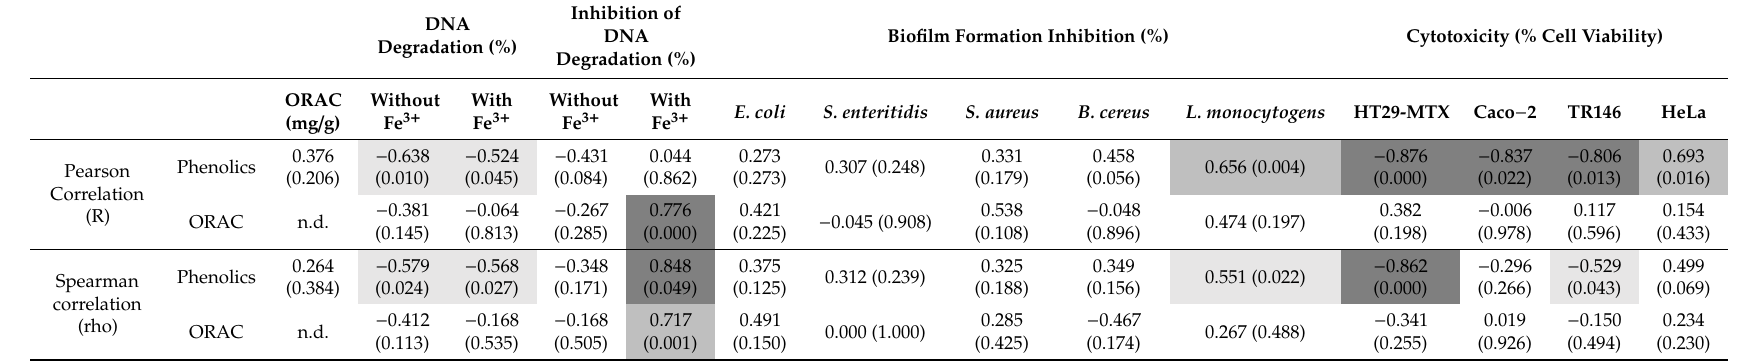
Table 5. Pearson ( R -value) and Spearman (rho-value) correlations and respective p -value in parenthesis. It should be noted that the table is labeled with a color code (only the significant correlations ( p < 0.05) are highlighted in grey cells, and more intense color represents the highest correlation values (three levels: light grey: R -value below 0.650; medium grey: R -value from 0.650 to 0.750; dark grey: R -value above